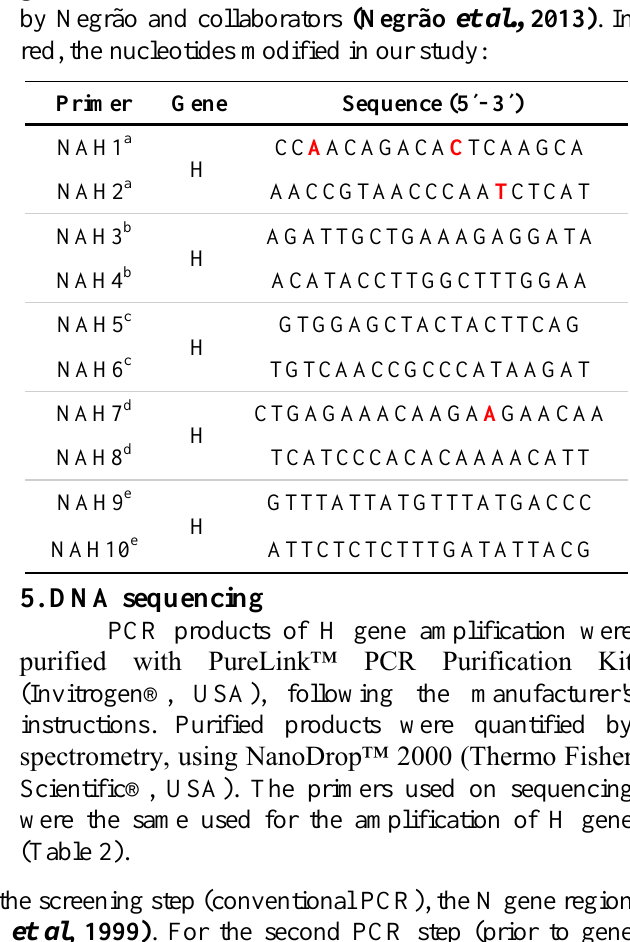
Table 2: Oligonucleotide primers used in our study. For the screening step (conventional PCR), the N gene region was targeted, based on Frisk and collaborators (Frisk et al , 1999) . For the second PCR step (prior to gene sequencing), the H gene was targeted, based on the protocol by N Negrão and collaborators (Negrão et al ., 2003) , with modifications marked in red. a: Primers PCR (Frisk et al ., 1999) ; b: Primers RT-PCR (Negrão et al .,